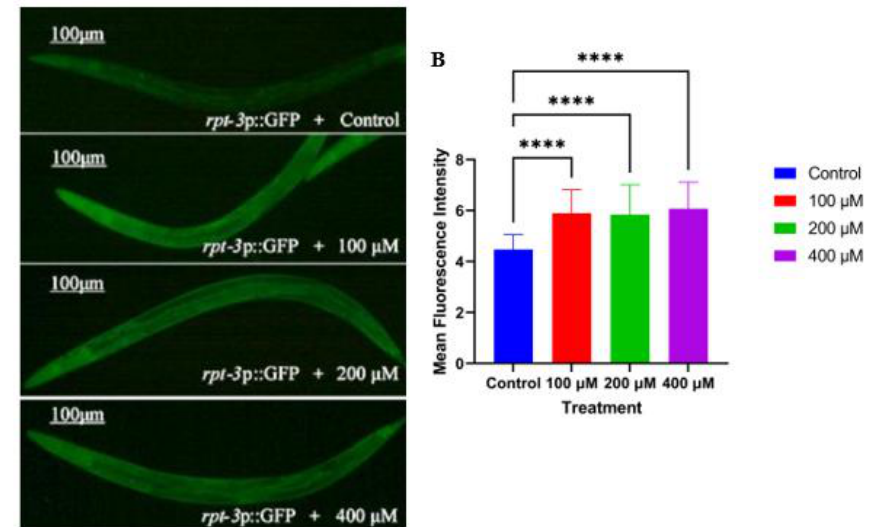
Figure 5. Caesalmin C promotes the expression of rpt-3 in GR2183 C. elegans . ( A ) The fluorescence pictures of worms in each treated group. ( B ) The quantitative analysis of worm fluorescence intensity in each treatment group. The 0.1% DMSO was used as control and the 100, 200, and 400 μM were the final concentrations of caesalmin C in NGM, respectively. Data are expressed as mean ± SD. The asterisk indicates significant difference compared to the respective control (**** p < 0.0001).